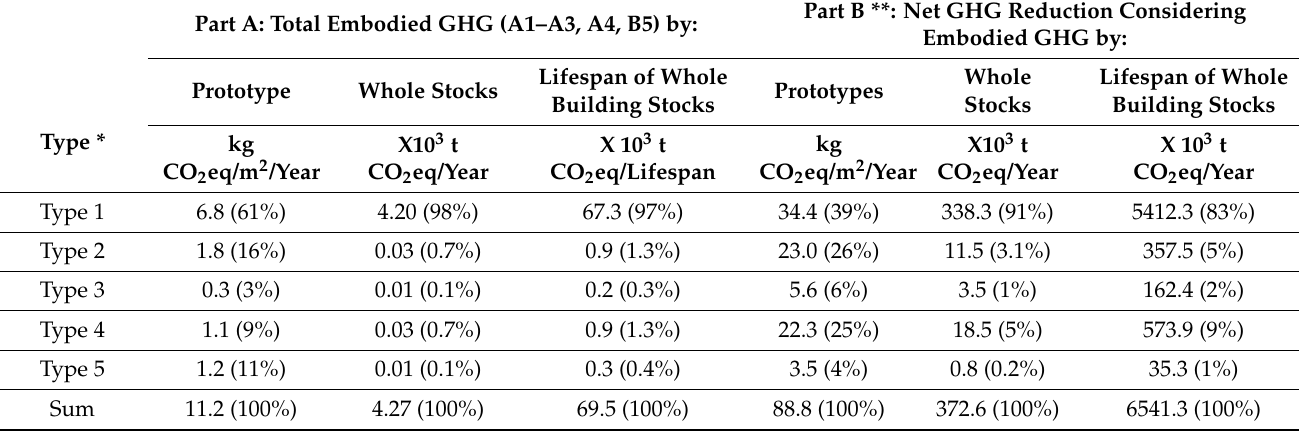
Table 10. Embodied GHG and net GHG emissions reduction of building stocks in the City of Greater Dandenong. Part A: Total Embodied GHG (A1–A3, A4, B5) by: